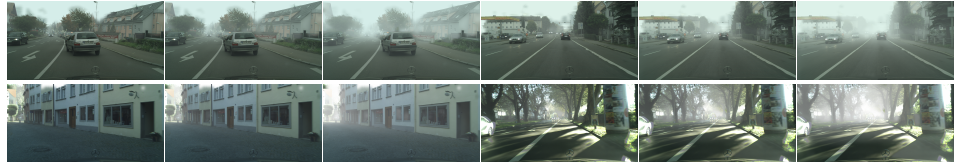
Figure 5. Sample images (four images with three fog density levels) from the “lindau” database [20].